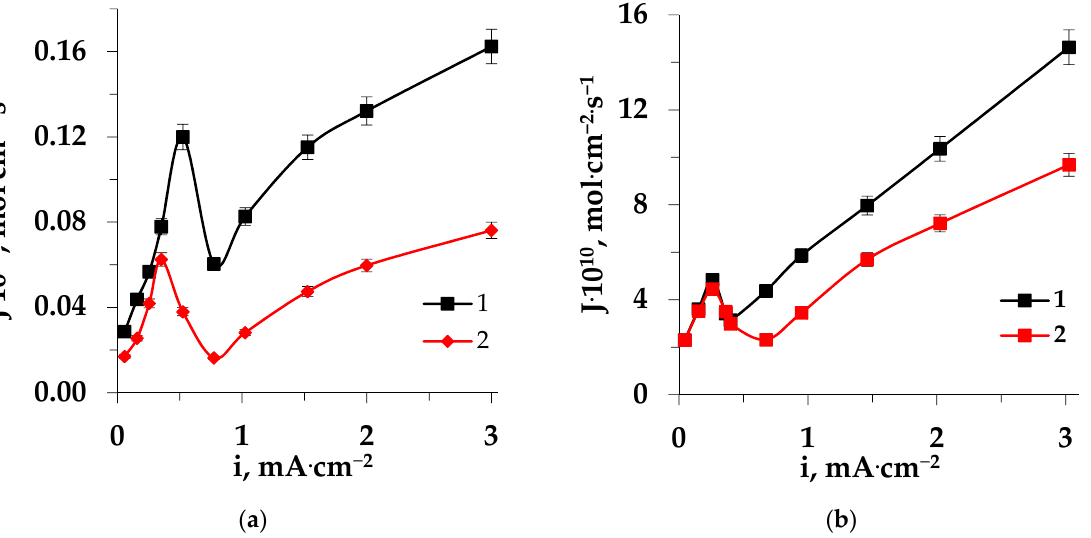
Figure 6. Dependences of the amino acid fluxes through the membranes on the current density during electrodialysis of Trp + NaCl ( a ) and Pro + NaCl ( b ) solutions: 1–MK-40, 2–MA-41.